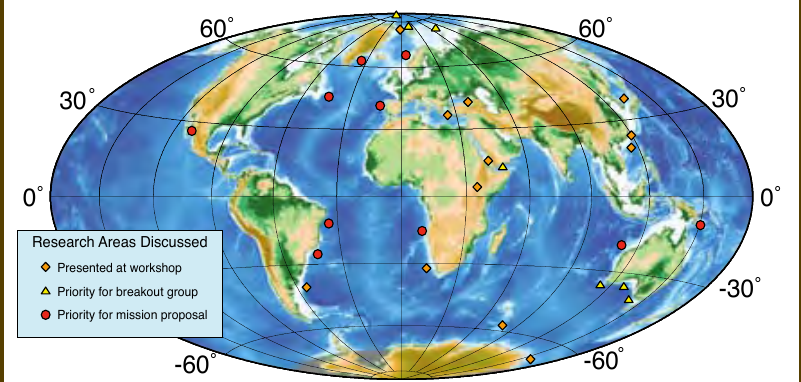
Figure 1. Global overview of continental rifts and rifted margins discussed at the workshop. Red dots highlight initial priority areas for